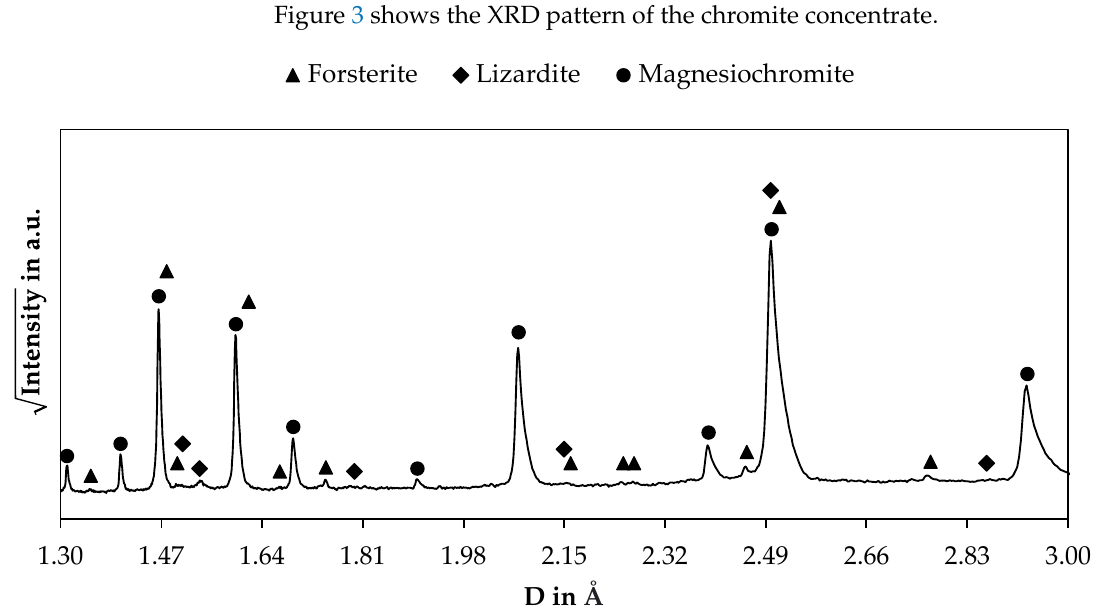
Figure 3. X-Ray Diffraction (XRD) pattern of chromite sample. Dominant peaks are explainable by a magnesiochromite spinel. The PDF-card 04-024-3779 is used in this case with the chemical formula Mg 0.56 Ti 0.01 Cr 1.33 Fe 0.51 Al 0.59 O 4 . Minor peaks are explainable by forsterite and lizardite, however due to the low intensity of those peaks, the content of those minerals is relatively low compared to that of magnesiochromite. For forsterite the PDF-card 00-004-0768 with the chemical formula Mg 2 SiO 4 is used and for lizardite the PDF-card 04-012-9602 with the chemical formula Mg 2.7 Fe 0.18 Al 0.3 Si 1.81 O 5 (OH) 4 is used.